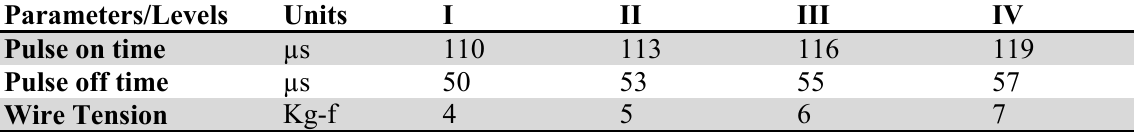
Machine parameters used in the experimentation Parameters/Levels